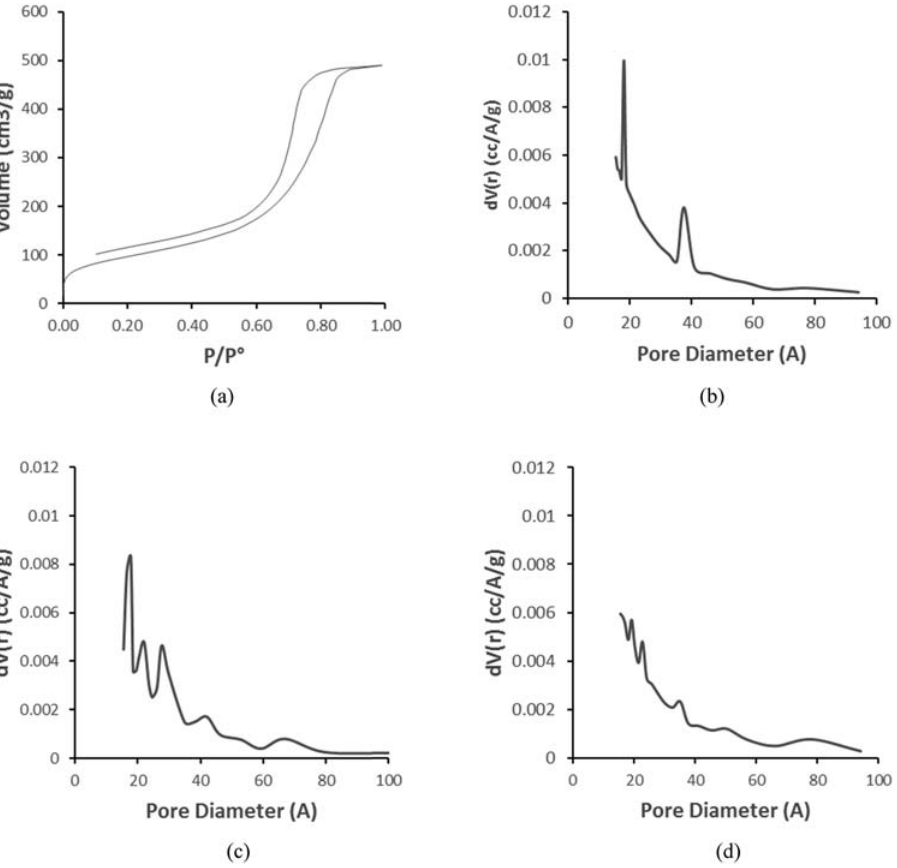
Figure 4: ( a ) N 2 adsorption – desorption isotherm of MSA 0 , ( b ) pore distribution of MSA 1 , ( c ) pore distribution of MSA 2 , and ( d ) pore distribution of MSA 3 .